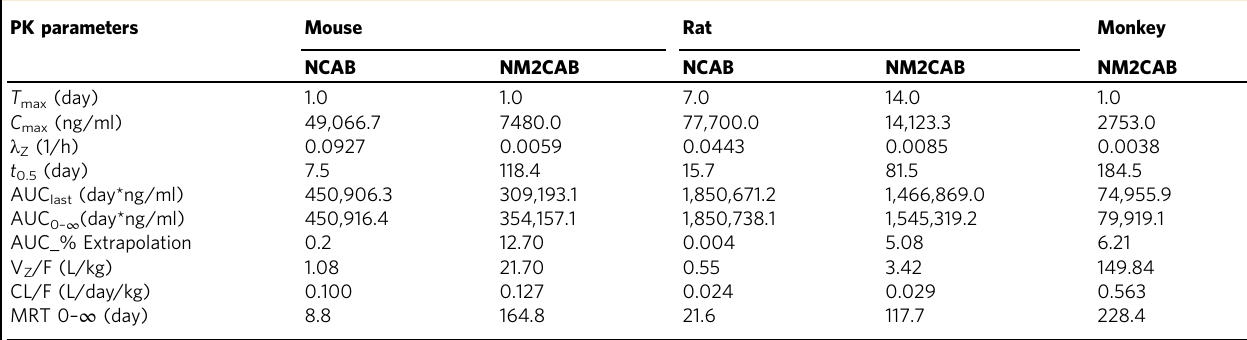
Table 1 CAB PK parameters after NCAB and NM2CAB